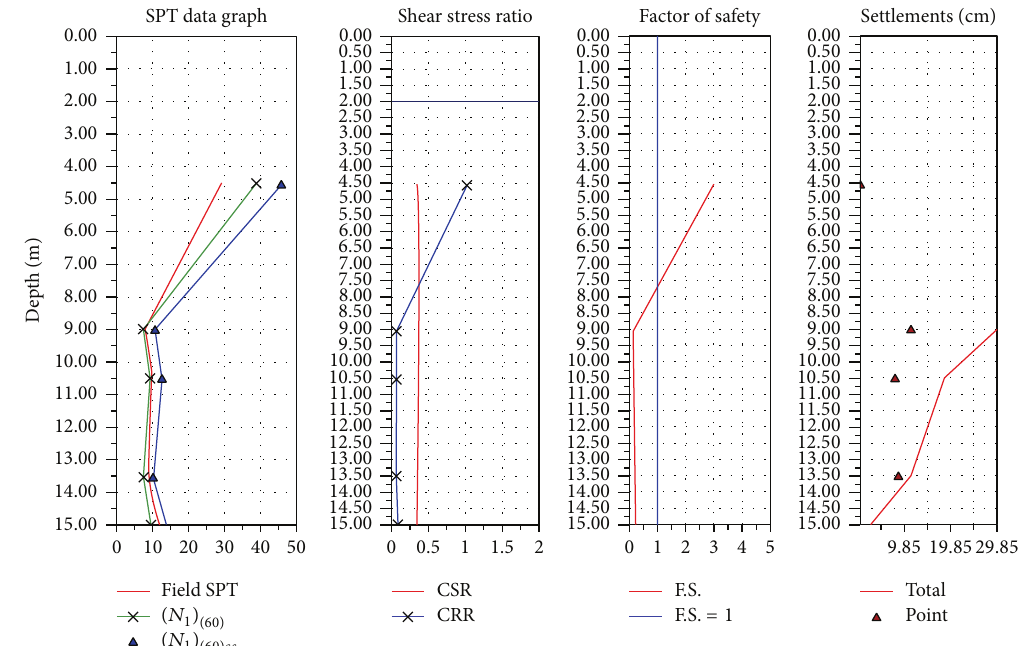
Figure 10: Borehole 23 was chosen to check and compare for liquefaction potential as a sample according to the SPT- 𝑁 values.